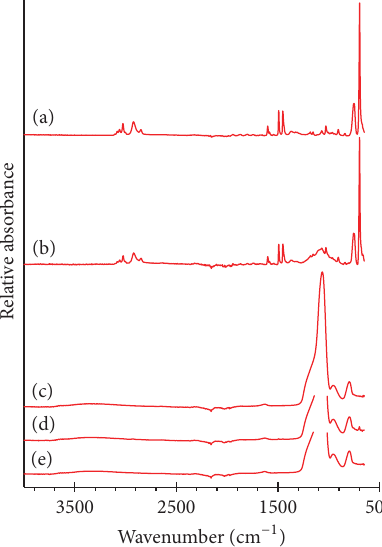
Figure 1: FTIR spectra for (a) polystyrene standard ( 𝑀 𝑤 6 × 10 5 g/ mol), (b) extracted polystyrene (M/I of 1000, polymerization time of 6 hours), (c) untreated silica, (d) silica modified by deoxygenated admicellar polymerization of styrene (M/I of 1000, polymerization time of 6 hours), and (e) silica modified by the control admicellar polymerization of styrene (M/I of 1000, polymerization time of 6 hours).